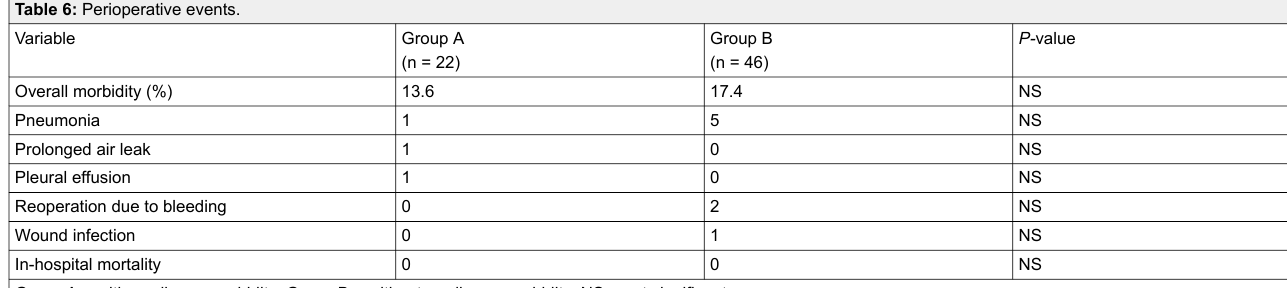
Table 6: Perioperative